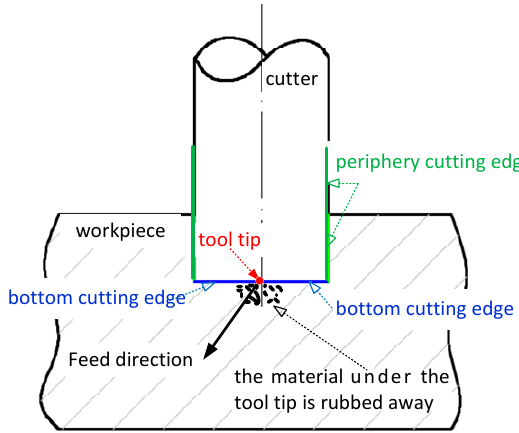
Figure 3. The material under the tool tip is rubbed away.